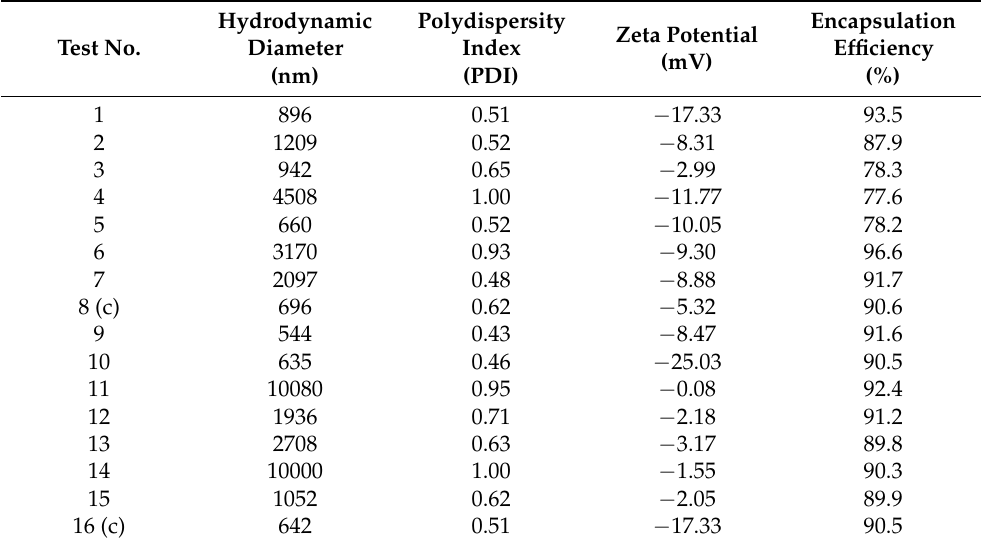
Table 2. Results obtained in the 2 3 CCRD for hydrodynamic diameter, polydispersity index,